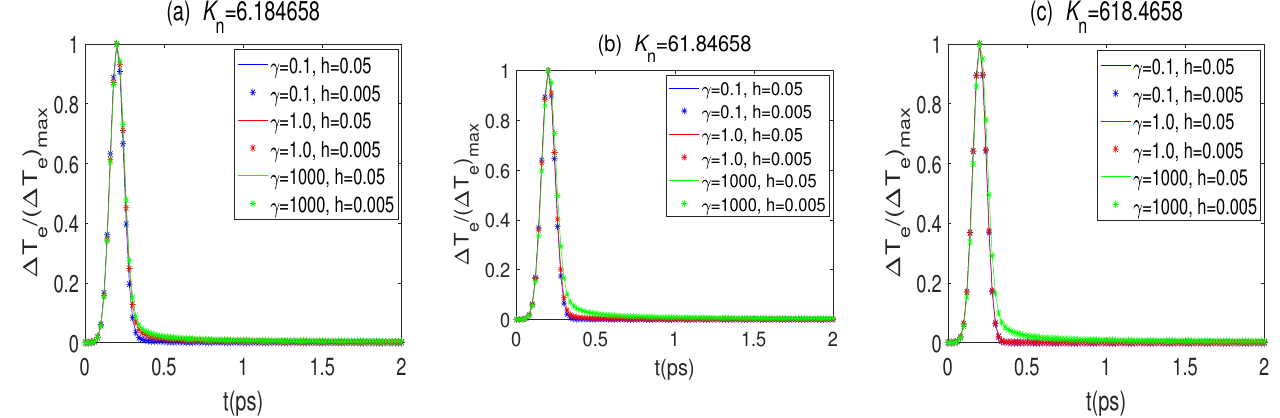
Figure 7. Changes in electron temperature ∆ T e / ( ∆ T e ) max and various K n , γ , and ( α , β ) = ( 0.3,0.9 )